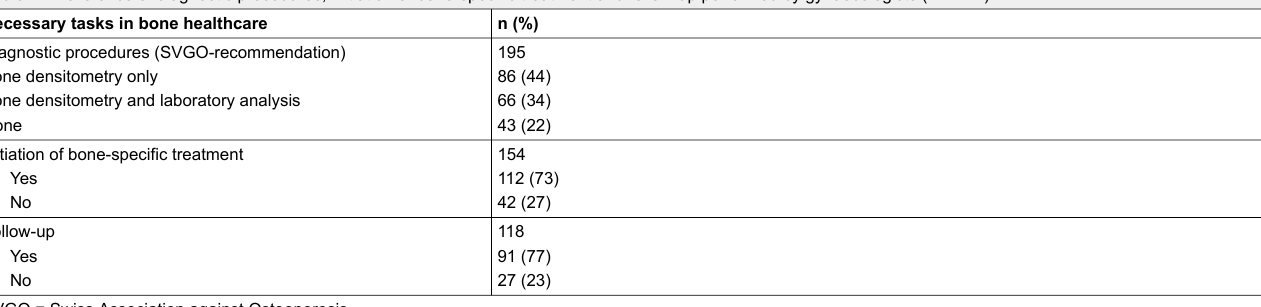
SVGO = Swiss Association against